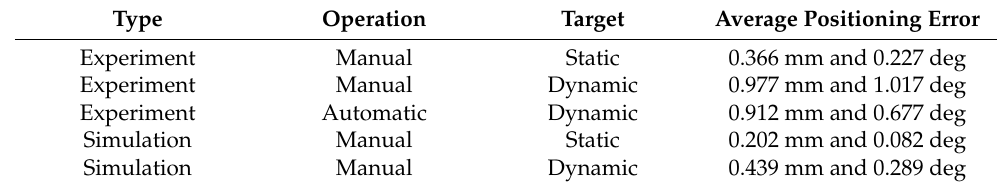
Table 2. Average positioning error of different groups.